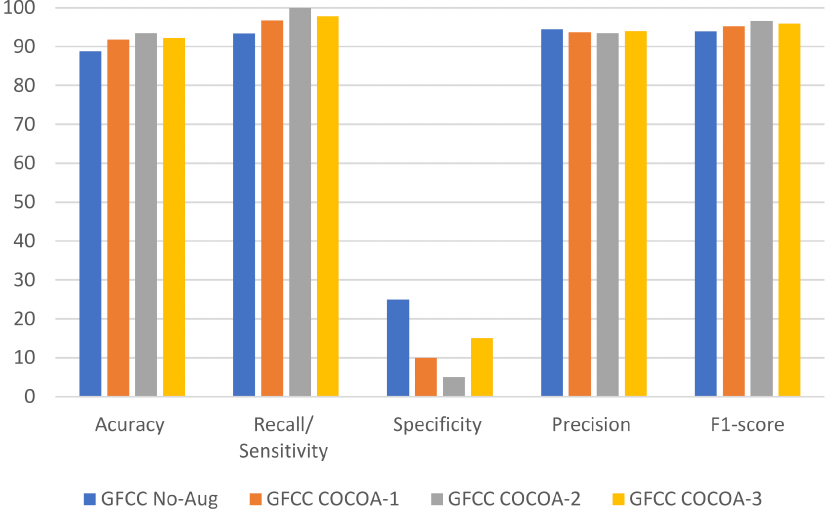
Figure 11. Comparison Metrics for classification of Healthy vs. Recovered Full (GFCC